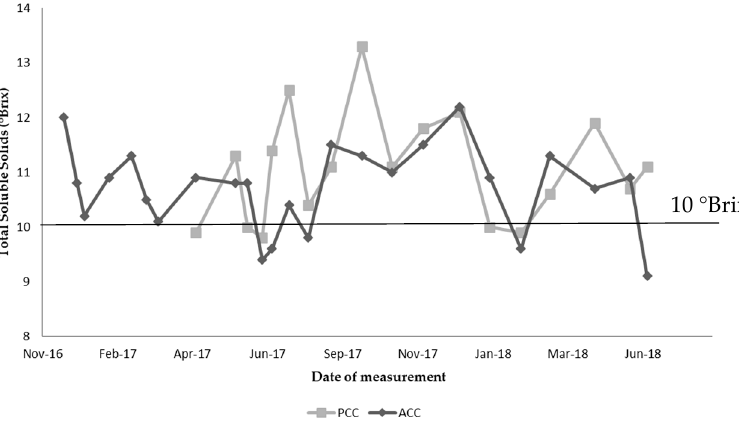
Figure 7. Total soluble solids content (TSS) changes in fruits harvested in passive climate control (PCC) and active climate control (ACC) modules throughout the growing cycle. The horizontal line marks 10 ° Brix value, commonly referred as the minimum required for papaya commercialization.